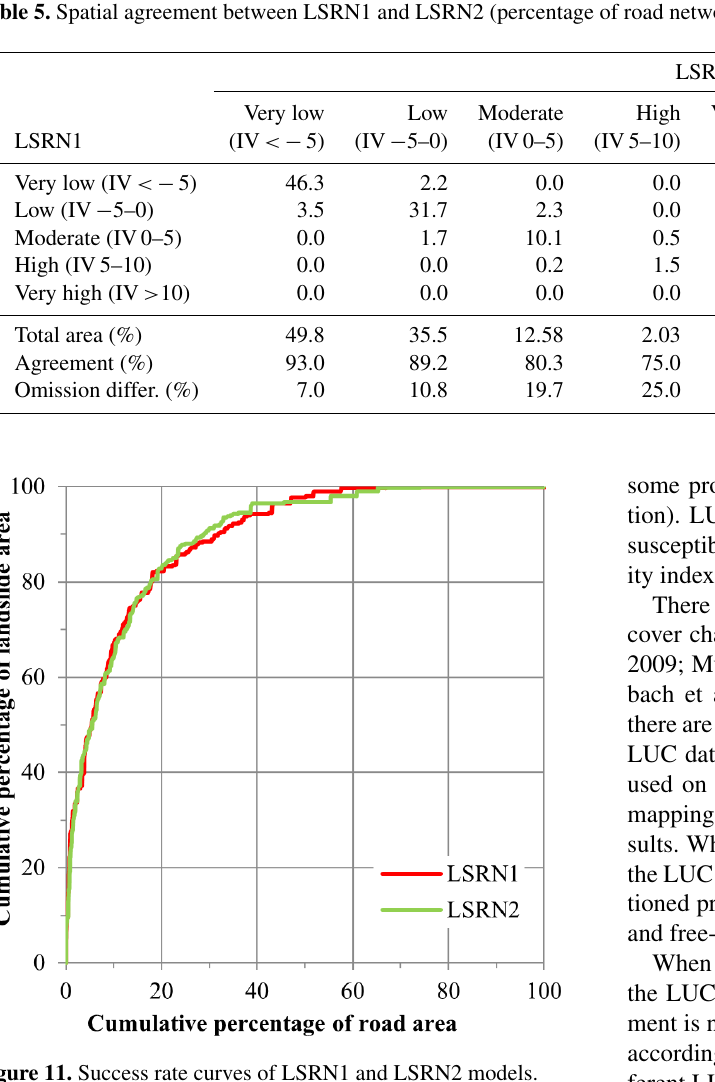
tal area of the road network, while LSRN2 is validated with 74 % of its